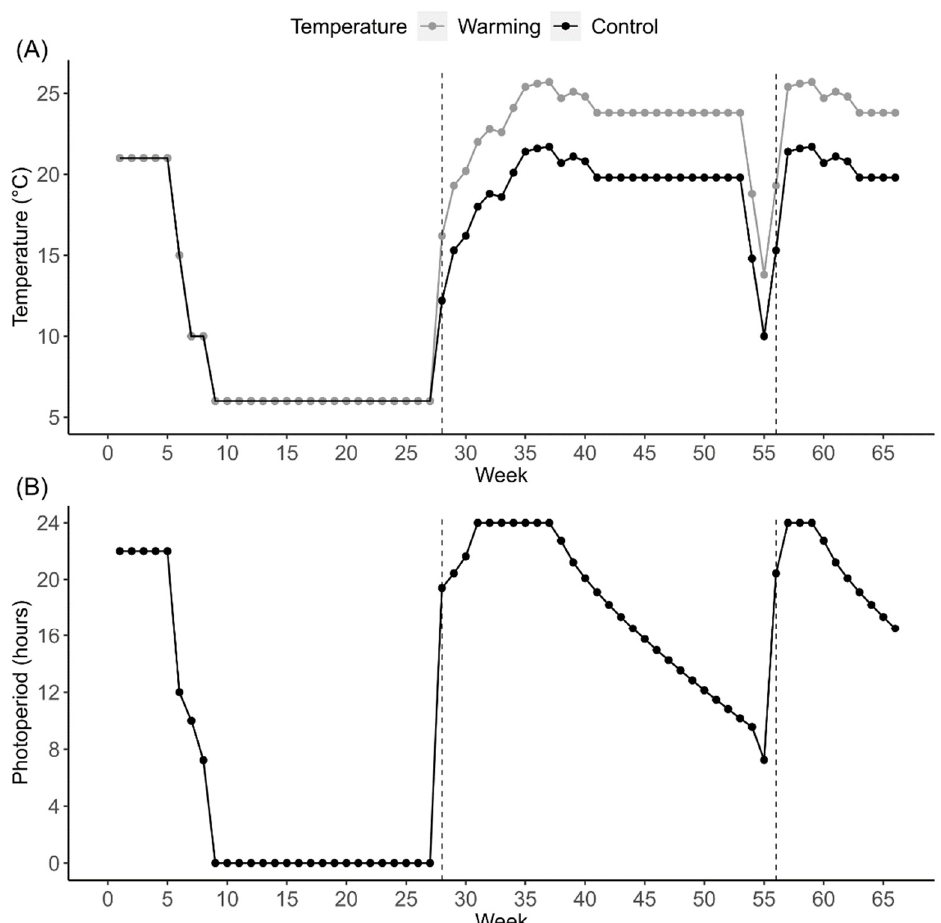
Figure 1. ( A ) Temperatures in °C and ( B ) photoperiods in hours of light during a 24 h cycle used during the experiment. Temperature treatment groups differed by 4 °C. The photoperiod was kept identical in both temperature treatments. The first growth season lasted from week 1 to week 8. The second growth season lasted from week 28 to week 55 (start is indicated by a dashed line to the left). The third growth season lasted from week 56 to week 66 (start is indicated by a dashed line to the right). During weeks 9 to 27 we installed winter conditions at 6 °C and total darkness. The short-term temperature and photoperiod drop at week 55 simulated the second winter condition.